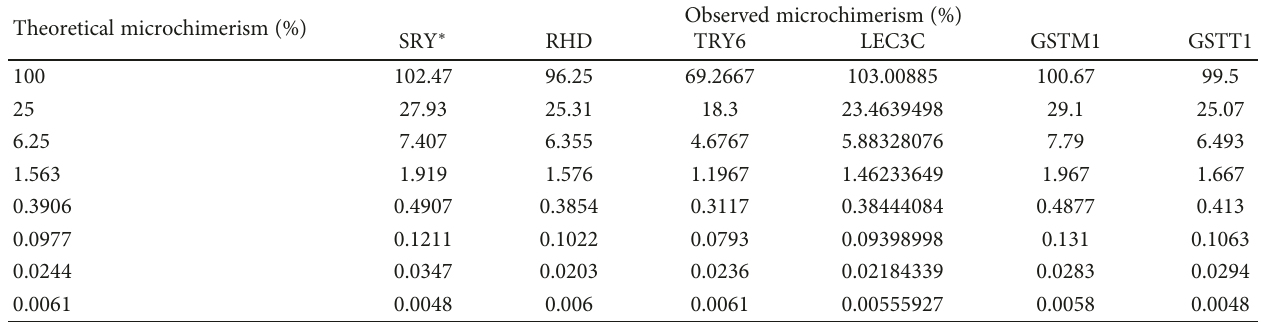
Table 4: Linearity.